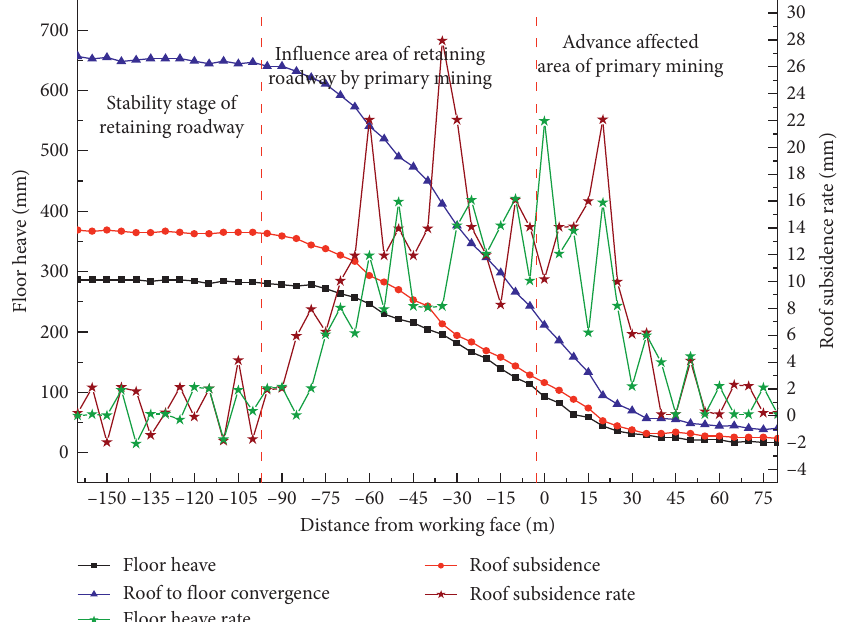
Figure 13: Deformation curve of the roof and floor of nonpillar gob-side entry retaining by roof cutting.